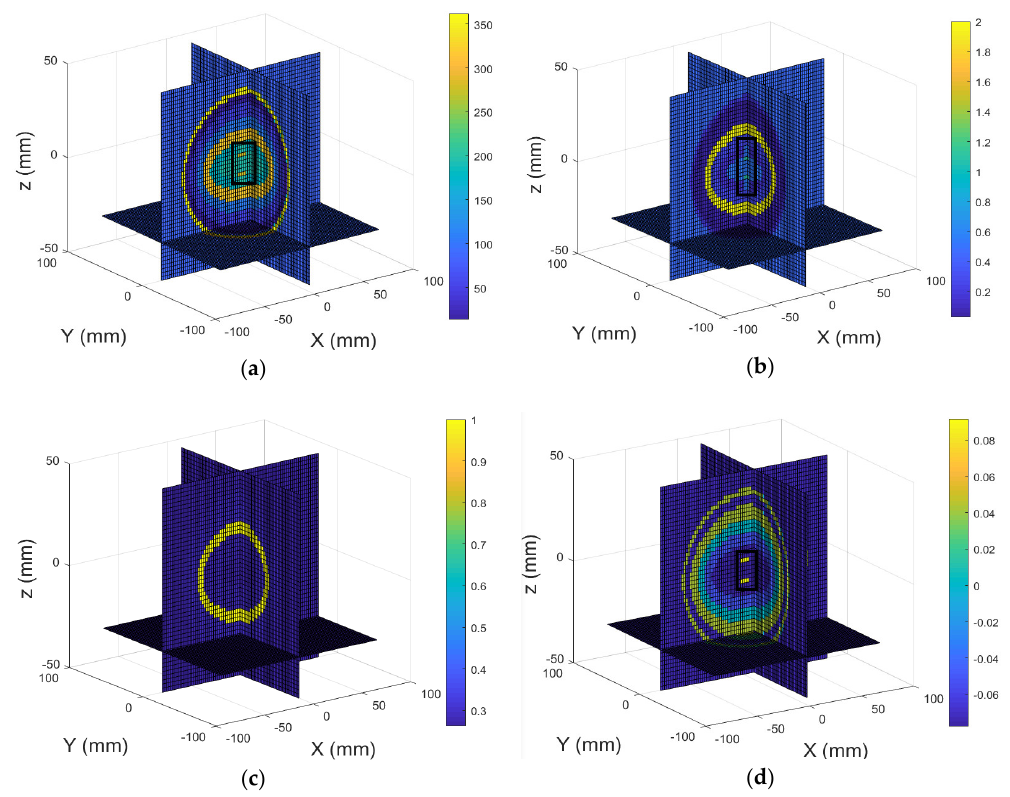
Figure 6. 3D view of the head model contains two lesions: ( a ) Real part; ( b ) Imagery part; 3D reconstructed images of the head model contains two lesions: ( c ) Real part; ( d ) Imagery part.